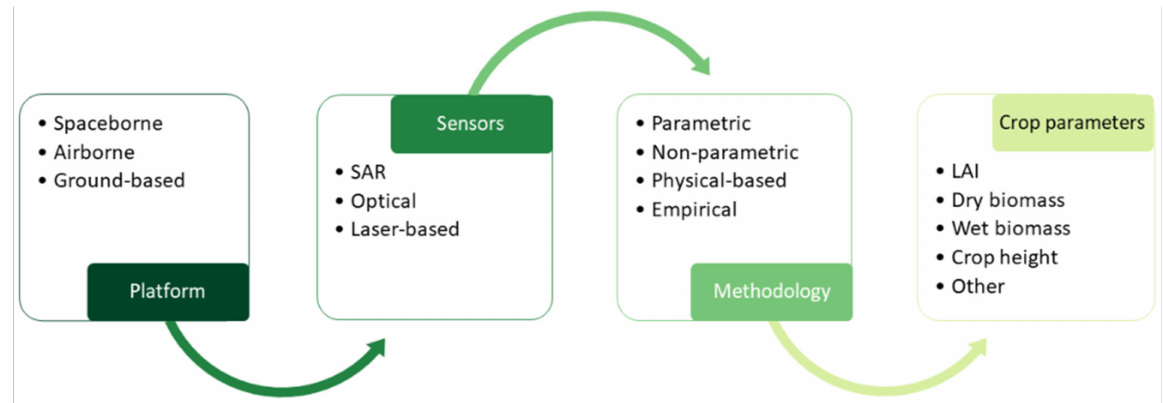
Figure 7. Essential parameters of meta-analysis articles assessed in this